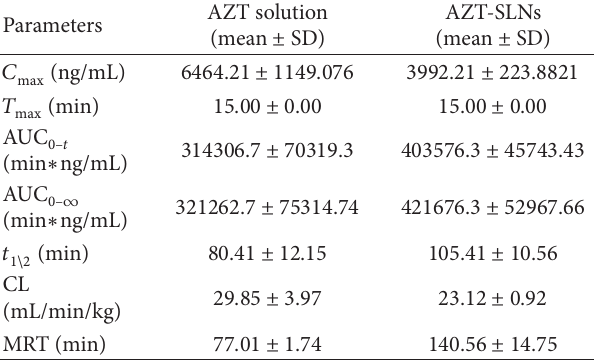
Table 1: Pharmacokinetic parameters for AZT solution and AZT- SLNs